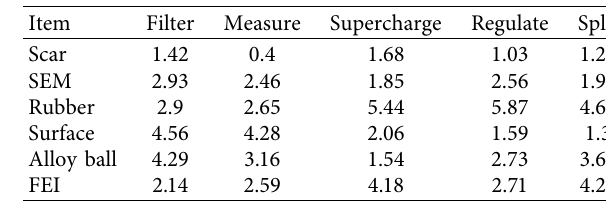
Table 2: Change of friction coefficient of drawing fluid B